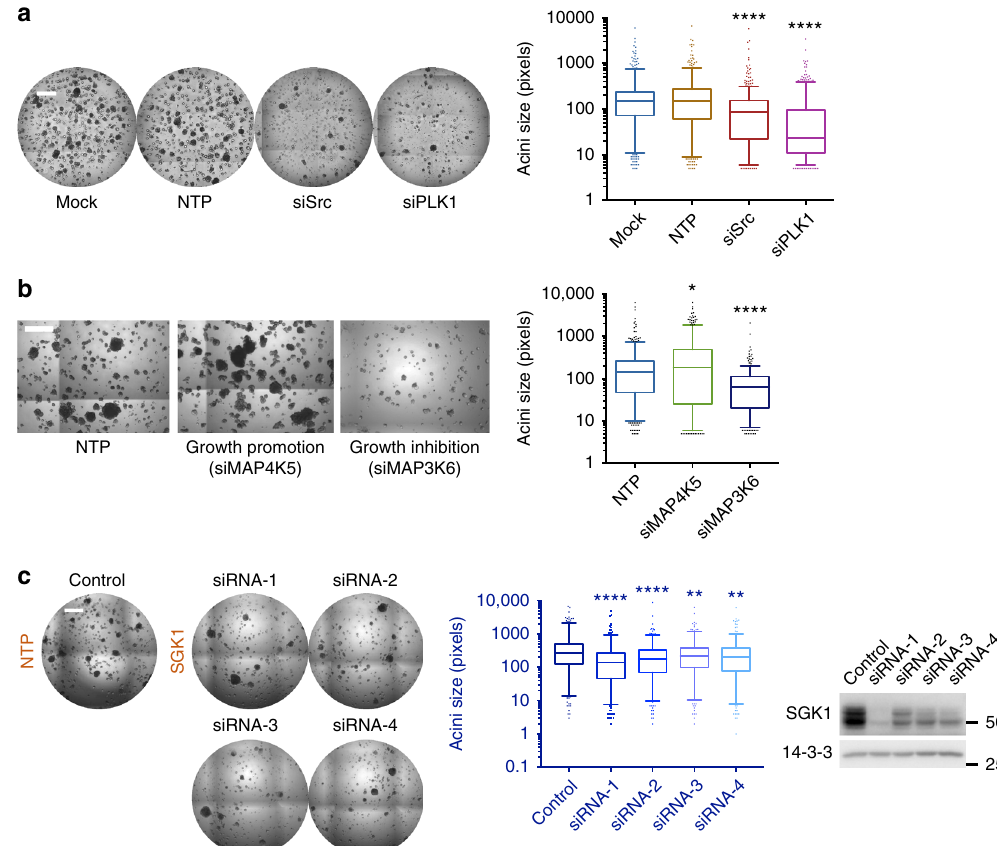
Fig. 4 Overview of 3D acini formation screen. a Optimization of functional screen conditions. 3D growth of MCF-10A_Src cells transfected with siPLK1 (positive control for screen), siSrc (against the expressed Src Y527F) and controls (mock and NTP). Scale bar represents 600 μ m. The size of >100 acini were measured and plotted on a box and whisker graph, with center line indicating the median, the upper and lower bounds of box indicating the 25th and 75th percentiles of the data, and the upper and lower whiskers indicating the 5th and 95th percentiles of the data. b Primary screen results for MAP4K5 (growth repressor) and MAP3K6 (required for acinar growth). 3D growth of MCF-10A_Src cells transfected with siSMARTpools as indicated. Scale bar represents 400 μ m. The quanti fi cation method and representation was as for ( a ). c Validation of the primary hit SGK1 by SMARTpool deconvolution. 3D growth of MCF-10A_Src cells transfected with individual siRNAs from the SMARTpool (siRNA1-4) (left). Scale bar represents 600 μ m. The quanti fi cation method and representation (middle) was as for ( a ). Lysates from cells in 2D culture transfected with the same siRNAs were Western blotted as indicated (right). a – c For box and whisker graphs * p < 0.05, ** p < 0.01, **** p < 0.0001 by Mann – Whitney